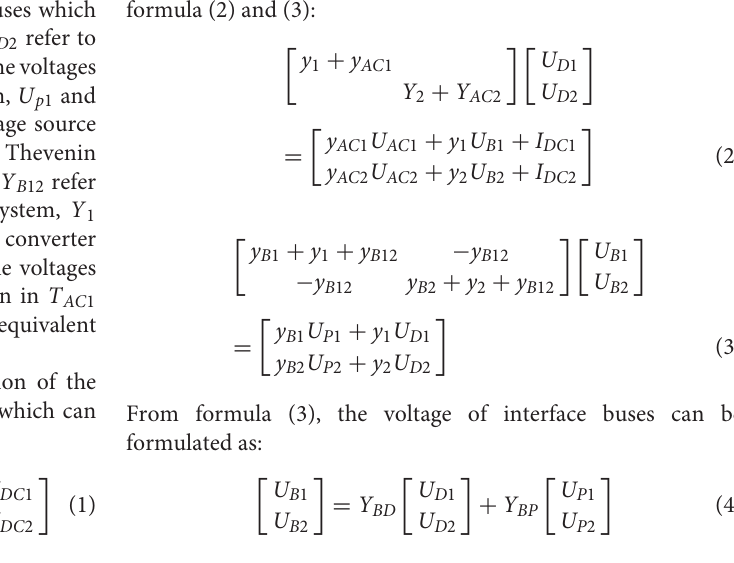
replaced by the Thevenin equivalence method. For